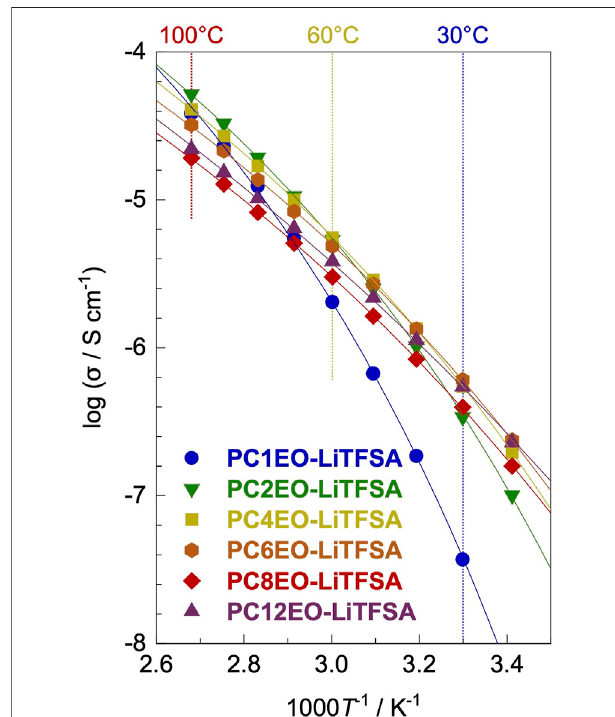
FIGURE 4| Ionic conductivities ( σ ) for PCmEO-LiTFSA( m = 1, 2, 4, 6, 8, and 12) plotted against 1000 T − 1 . Vogel – Tammann – Fulcher (VTF) fi tting curves are shown in solid line. The measurements were performed at the temperature range of20 − 100 ° C.Each symbol shows m =1 (bluecircle), m = 2 (green down triangle), m = 4 (yellow square), m = 6 (orange hexagon), m = 8 (red diamond), and m = 12 (purple